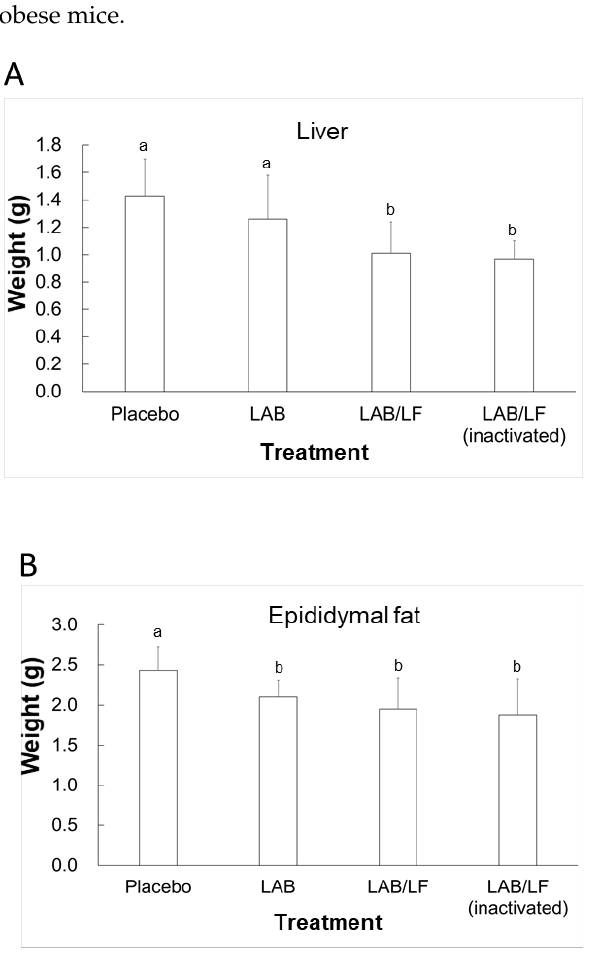
Figure 2. Tissue weights of liver ( A ) and epididymal fat ( B ) in DIO mice treated with three types of probiotic mixture for four weeks. The treatments are described in the legend of Table 1. Results are presented as means ± SDs. a, b Means with different letters are significantly different ( p < 0.05) according to Student ’ s t -test.